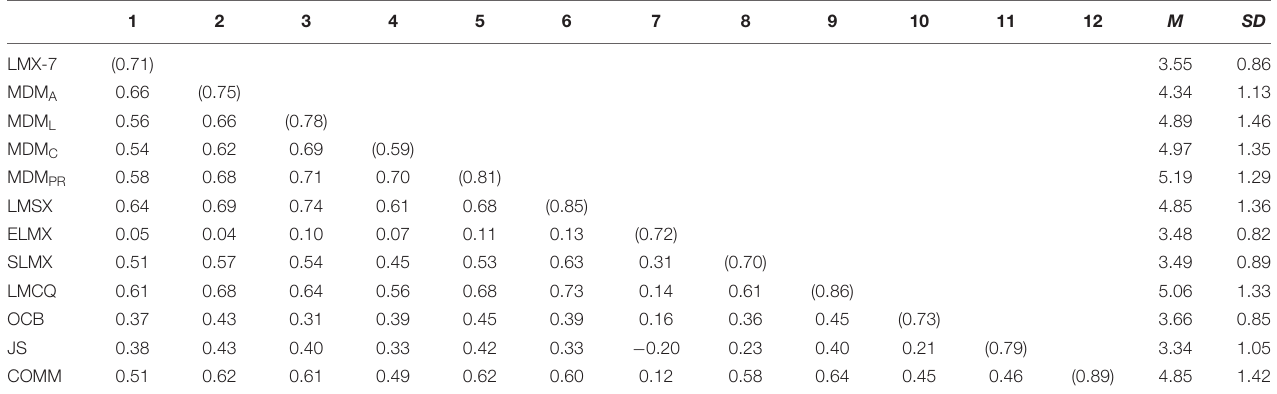
TABLE 5 | Correlations, alphas, means, and standard deviations (Study 2).